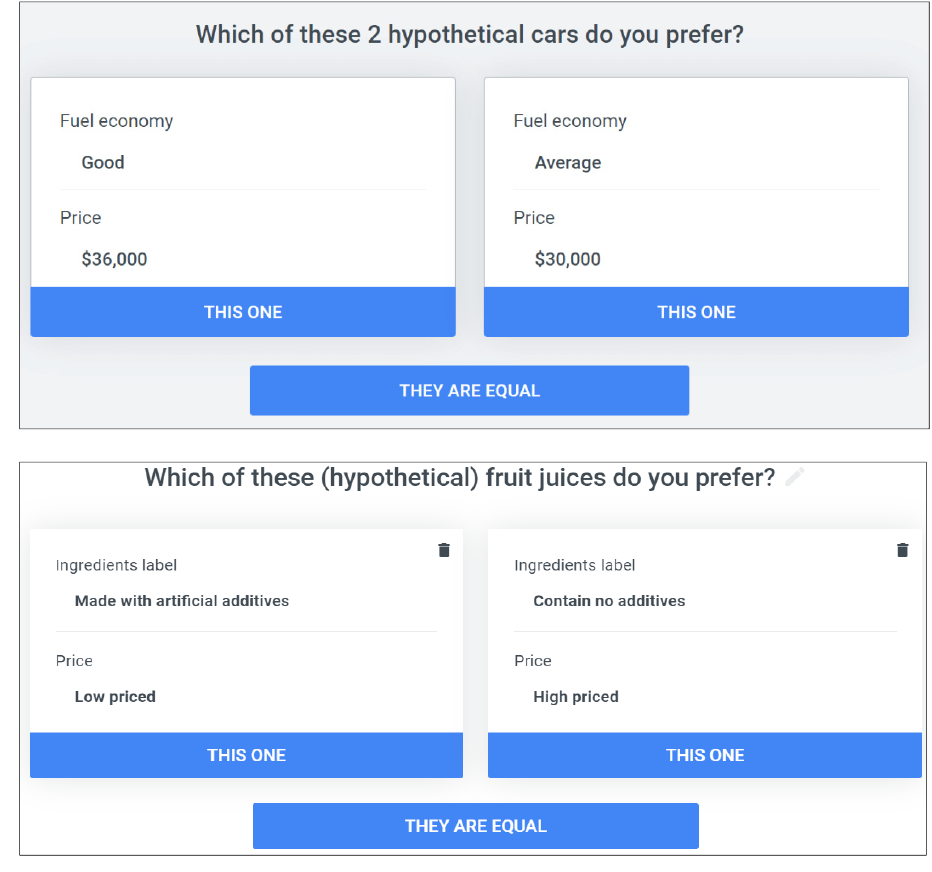
Figure A2. Examples of questions within the 1000minds